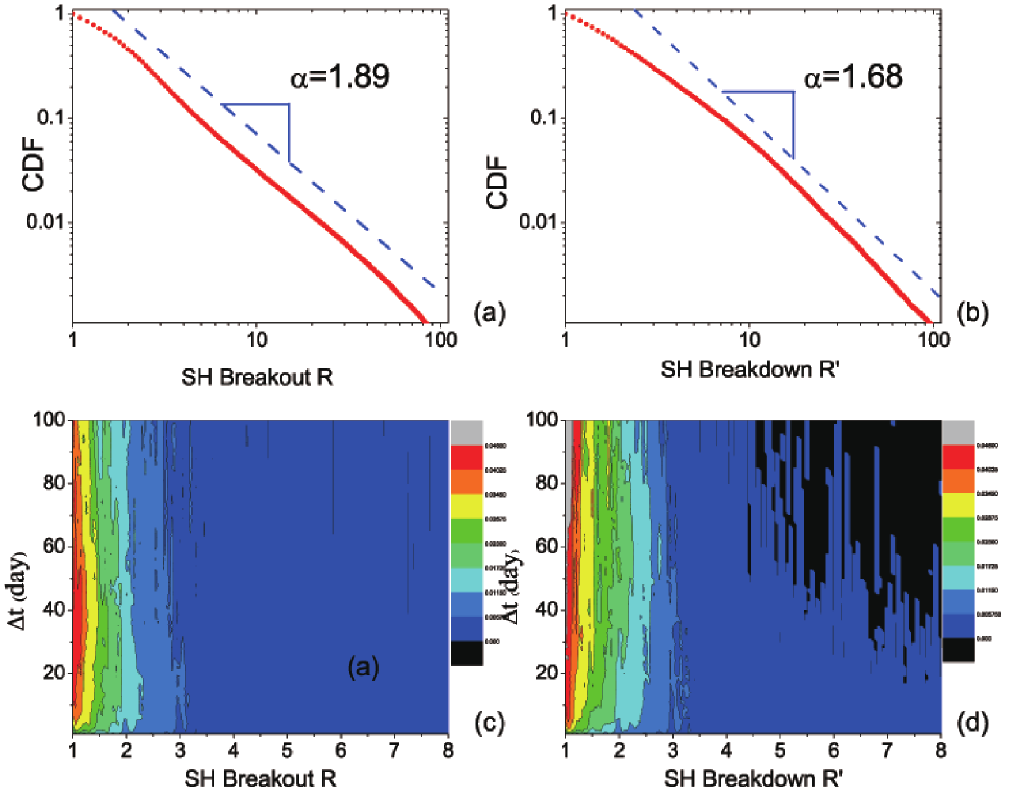
Figure 4. Same as Fig. 2, but for the SH Index in the Chinese stock market. The dash line is a guide to the eye. Regarding the fitting, more details are listed in Table 3.